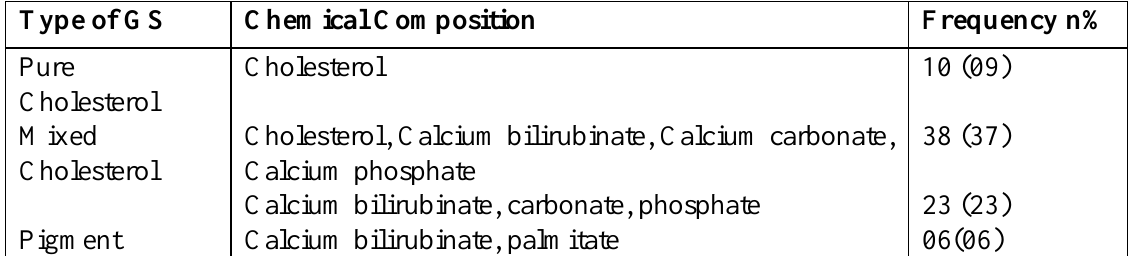
Table3: Chemical composition of gallstones by FTIR. Type of